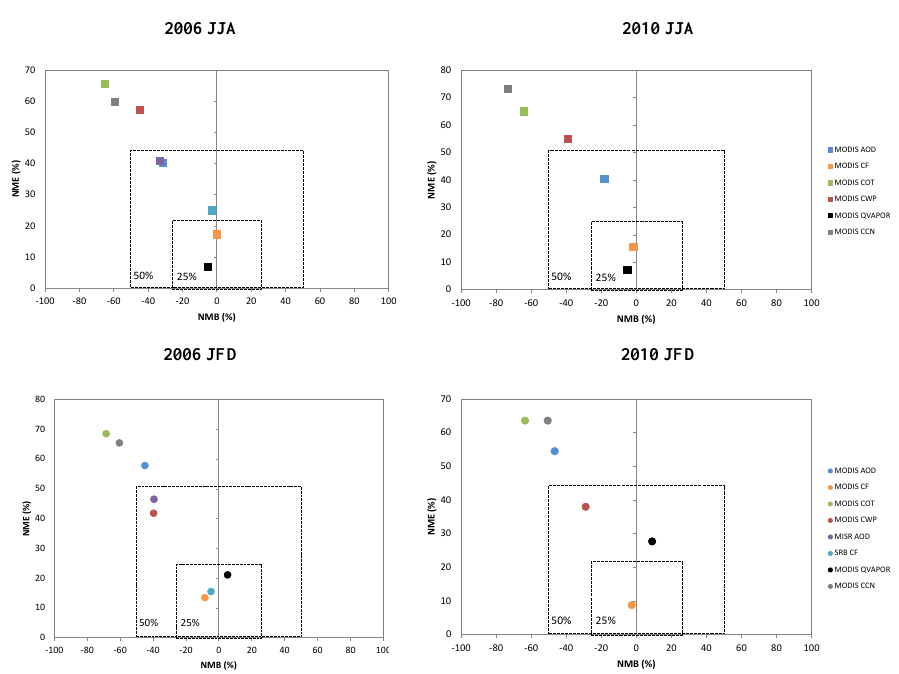
Figure 10. Comparison of soccer plots for JFD and JJA 2006 and 2010 evaluation of aerosol and cloud variables. Multiangle Imaging SpectroRadiometer (MISR) AOD, and Surface Radiation Budget (SRB) CF Obs data were not available for 2010.